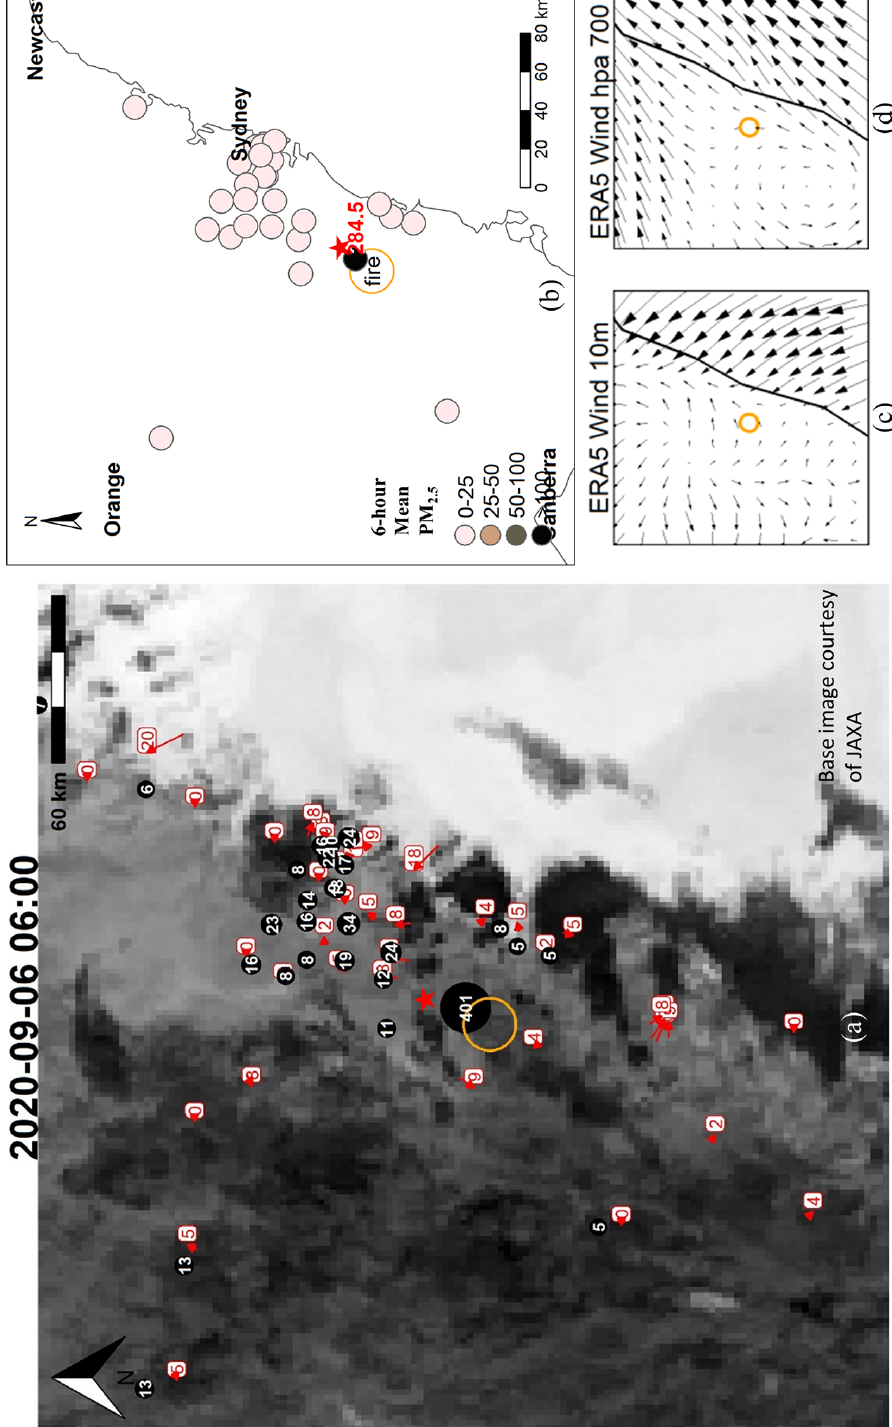
Figure A7. HRB morning. The highest mean morning HRB PM 2 . 5 was 284.5µgm − 3 at Bargo AQS (red star) 10km from the HRB. This example differs from the other panels in that the PM 2 . 5 impact was local only: no other AQSs had > 25µgm − 3 for this morning (b) . None of the examples (Figs. A1–A6) had an AQS at such a close distance. The 10m winds (c) suggest light winds from the fire towards the AQS. The BOM winds near the fire (a) varied in direction but were light. The wind speeds were likely too low to carry smoke far enough north to impact AQSs in Sydney or AQSs in other directions. This HRB was ignited the previous day under W/SW winds but did not noticeably increase PM 2 . 5 at any AQS. On the day after this morning period, strong northerly winds occurred and PM 2 . 5 at Bargo dropped below 10µgm − 3 .